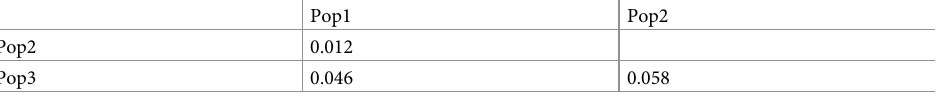
Table 5. Pairwise comparison of Nei’s G ST for loci BT, IGS, ITS, and TEF for Fusarium populations a .